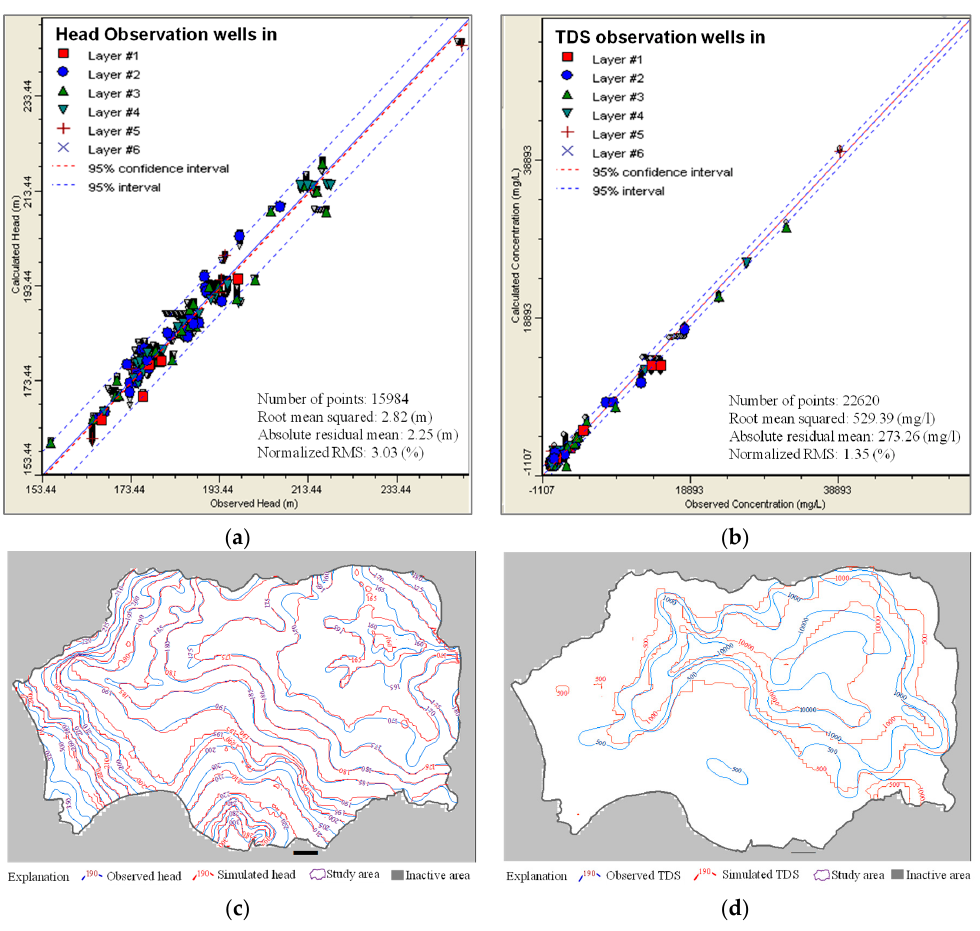
Figure 13. Observed versus simulated heads ( a ), simulated salinity ( b ) with the statistical results of model A and the comparison of observed and simulated of equipotential lines ( c ), and salinity ( d ) in layer 3 of model A at the end of 2015. Table 4 . Model performance during calibration and validation.